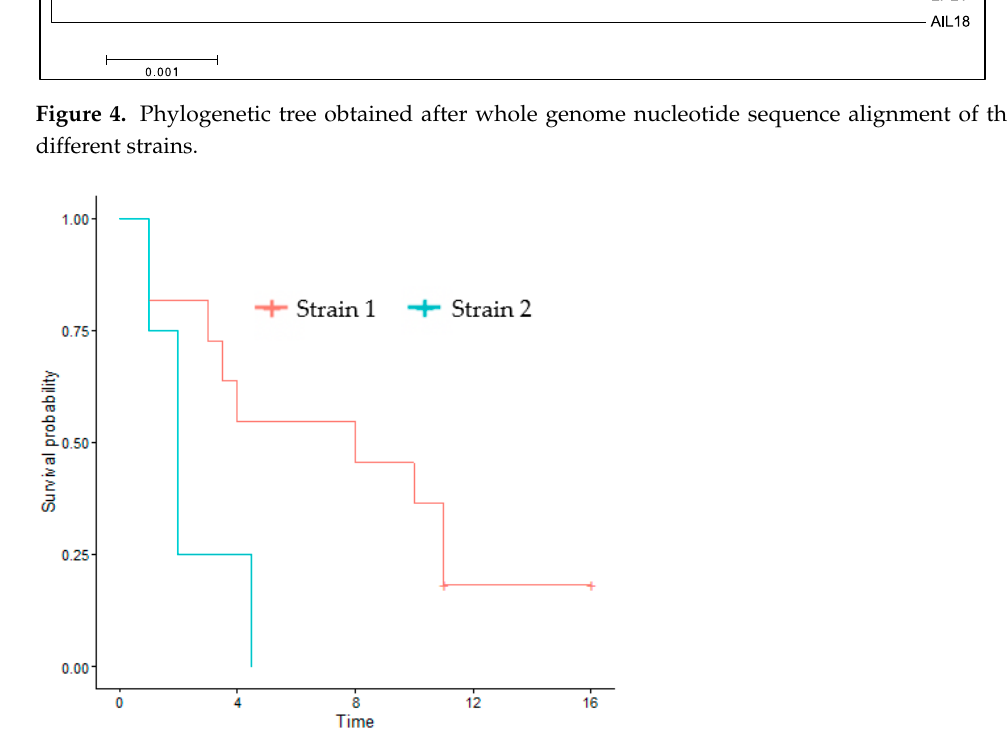
Figure 5. Kaplan-Meier curve showing significant differences in the survival of AITL patients carrying strain 1 compared to those carrying strain 2 ( p = 0.048).